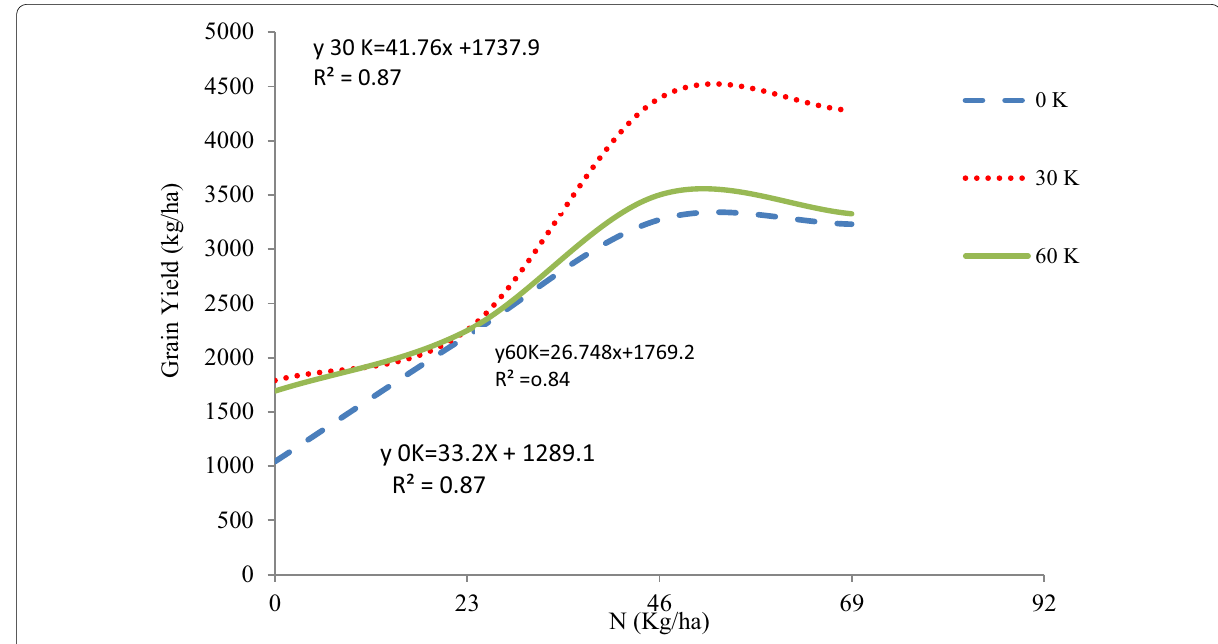
Fig. 3 Relationship between interaction effects of N x K on grain